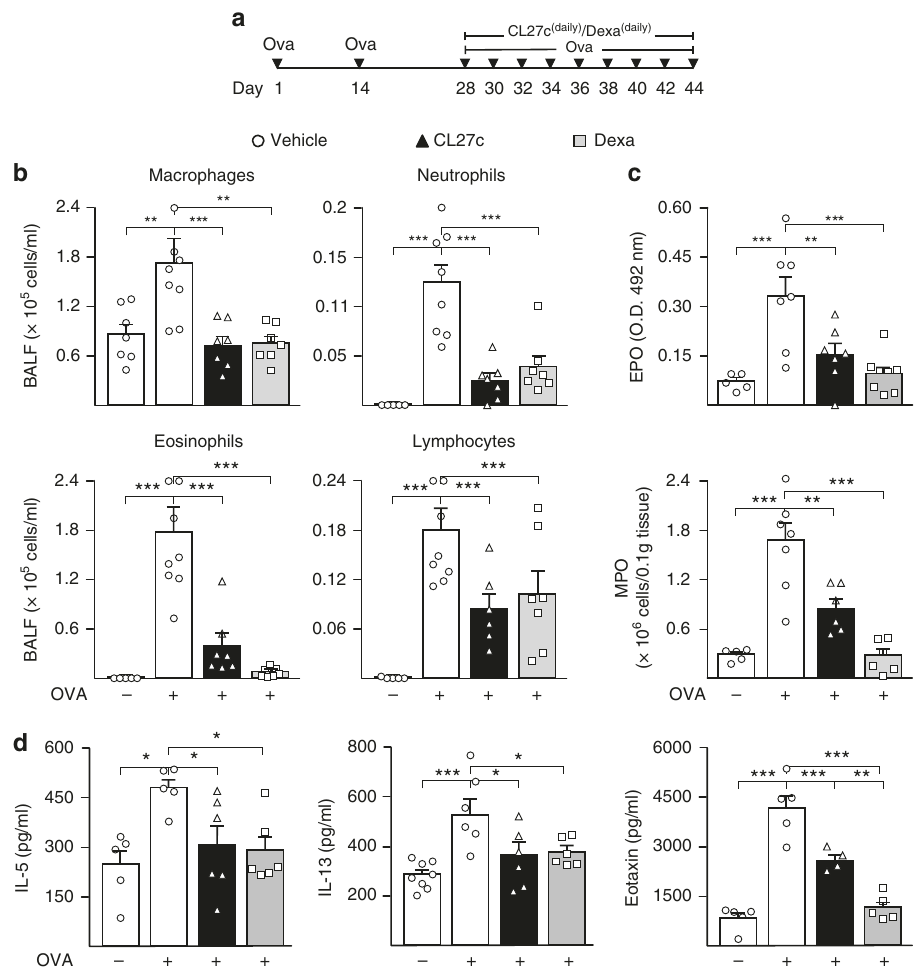
Fig. 3 CL27c decreases leukocyte in fi ltration into the lungs and production of in fl ammatory markers in OVA-induced chronic allergic asthma model. a Protocol of OVA-induced chronic allergic asthma and daily treatment regimen with aerosolized CL27c (2 mg/ml) or Dexamethasone (Dexa, 5 mg/kg, i.e.; positive control). b Quanti fi cation of in fi ltrating macrophages, neutrophils, eosinophils, and lymphocytes in BALF after treatment with either CL27c or Dexamethasone (Dexa) (from left to right, macropages n = 7, 8, 7, 7, neutrophils n = 5, 8, 7, 7, eosinophils n = 5, 8, 7, 7, and lymphocytes n = 5, 8, 6, 7 independent experiments, respectively). c Measurement of the accumulation of neutrophil myeloperoxidase (MPO) and eosinophil peroxidase (EPO) in lung tissues after treatment with either CL27c or Dexamethasone (from left to right, EPO n = 5, 7, 7, 8 and MPO n = 5, 7, 6, 5 independent experiments, respectively). d Quanti fi cation of in fl ammatory cytokines (IL-5 and IL-13) and of the chemokine eotaxin after treatment with either CL27c or Dexamethasone (from left to right, IL-5 n = 5, 5, 6, 6, IL-13 n = 8, 6, 6, 6, Eotaxin n = 5, 5, 4, 5 independent experiments, respectively). Results represent mean ± s.e.m., * P < 0.05, ** P < 0.01, *** P < 0.001 determined using one-way ANOVA followed by Bonferroni post-hoc